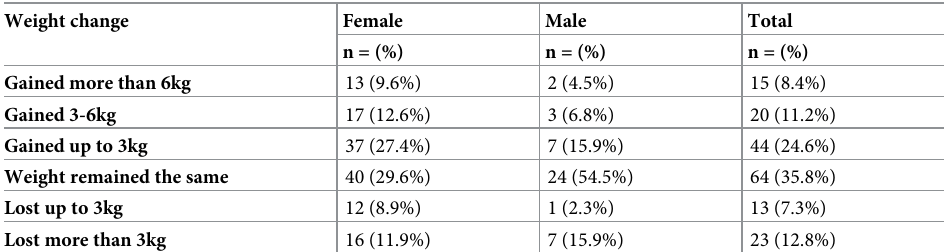
Table 1. Changes in weight reported since the start of COVID-19 restrictions. Weight change